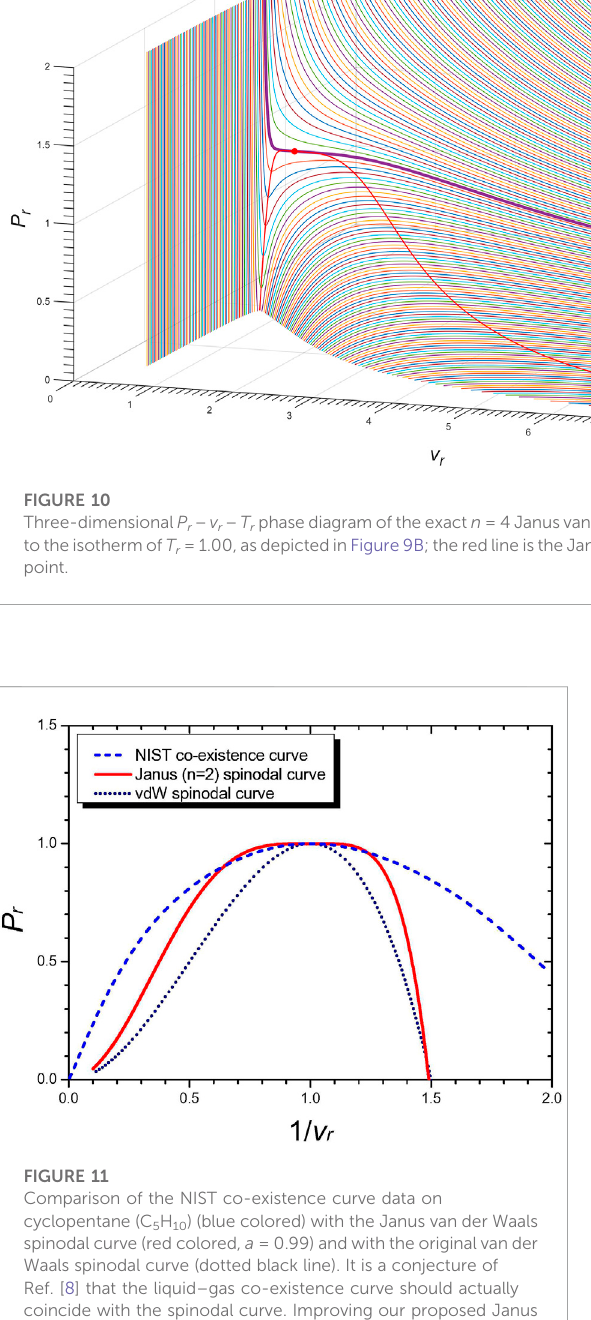
Figure 9 shows the isothermal curves of nitrogen (N 2 ) at T r = 1.01 ( A ), T r = 1.00 ( B ), and T r = 0.99 ( C ), respectively. They are drawn by the NIST data and further by the three equations: the